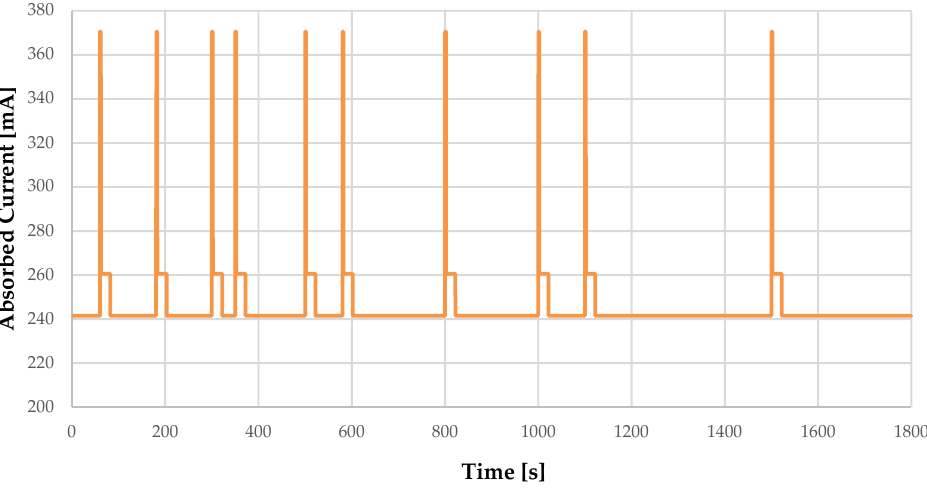
Figure 5. Time trend of the absorbed current during a patrol flight using camera and GPS.